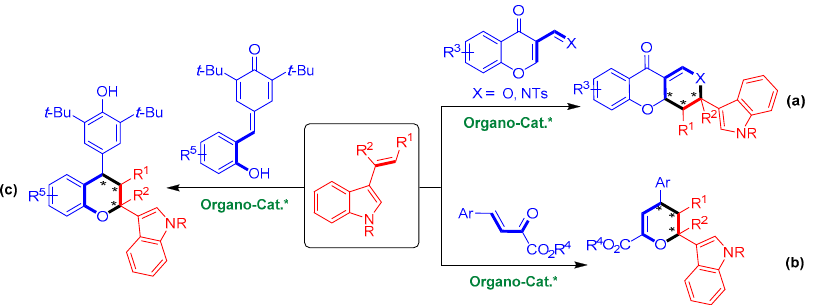
Figure 3. Limited examples of organocatalytic asymmetric [2 + 4] cycloadditions of 3-vinylindoles with oxa -dienes. ( a ) With chromone-derived oxa -dienes; ( b ) With β , γ -unsaturated α -ketoesters; ( c ) With ortho -hydroxyphenyl-substituted para -quinone methides. The asterisk * indicates chiral cen- ter.